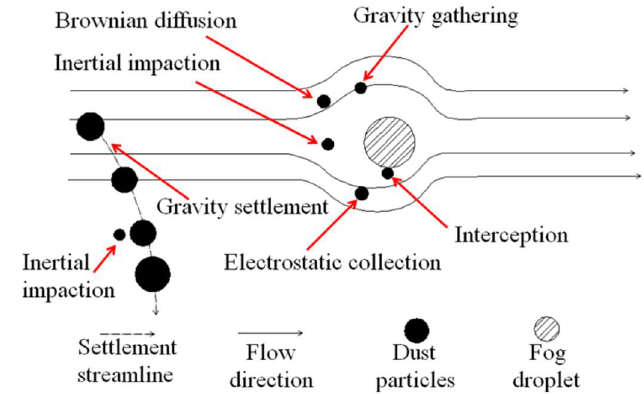
Figure 3. Dust suppression process in spraying device.